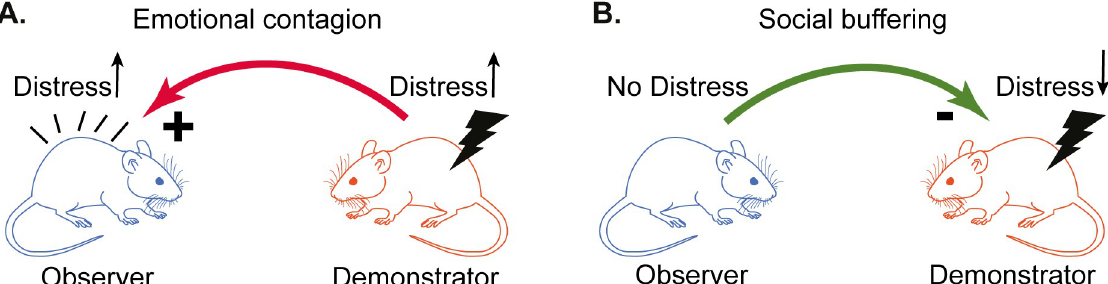
Fig 1. Emotional contagion and social buffering paradigms. (A) A schematic representation of typical paradigms used to investigate emotional contagion. An observer rat witnesses a demonstrator rat receive an electric foot shock. The shock induces fear and pain responses in the demonstrator, which in turn is unidirectionally transferred to the observer, which shows increased freezing thought to indicate an increase in distress. In these paradigms, the variable of interest is the amount of freezing of the observer. (B) A schematic representation of the social buffering paradigm. A demonstrator rat receives an electric foot shock. The fear response of the demonstrator, freezing in particular, is reduced in the presence of an observer rat. The variable of interest is the amount of freezing of the demonstrator.